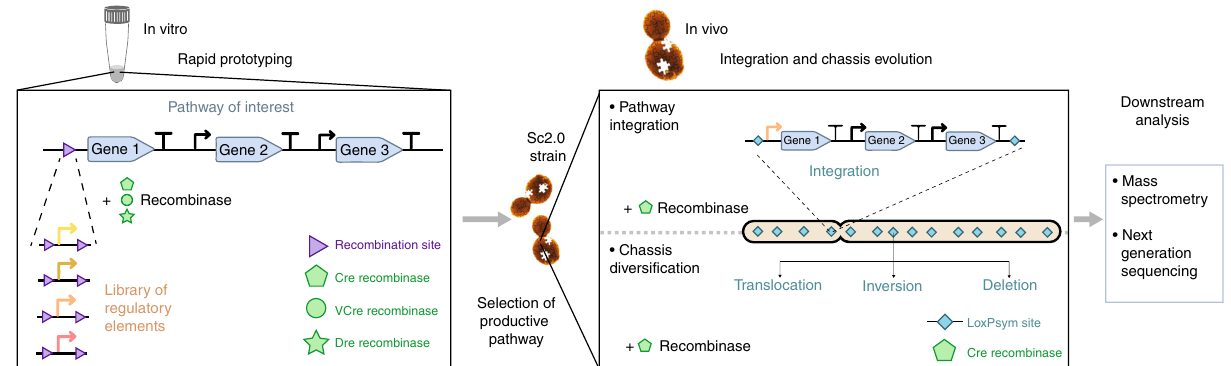
Fig. 1 Schematic overview of the SCRaMbLE-in toolkit for metabolic engineering. Once designed, the synthetic pathway of interest will be rapidly prototyped in vitro. The pathway is pre-assembled in such a way that all genes are assembled with respective regulatory elements, except that one key gene is left “ promoter-less ” , having a recombination site upstream. Three recombination systems, Cre-loxP, VCre-Vlox, and Dre-rox, were developed to integrate a range of promoters upstream to the key gene in the pathway. The assembled library is transformed into yeast and potentially productive pathways are selected and integrated in vivo in the next step. The selected productive pathways are fl anked with a pair of loxPsym sites and can subsequently be integrated into the synthetic chromosomes through SCRaMbLE, and simultaneously the synthetic yeast chassis undergoes whole-genome rearrangement to result in strain optimization. The successful integrated strains will be pro fi led with mass spectrometry analysis and